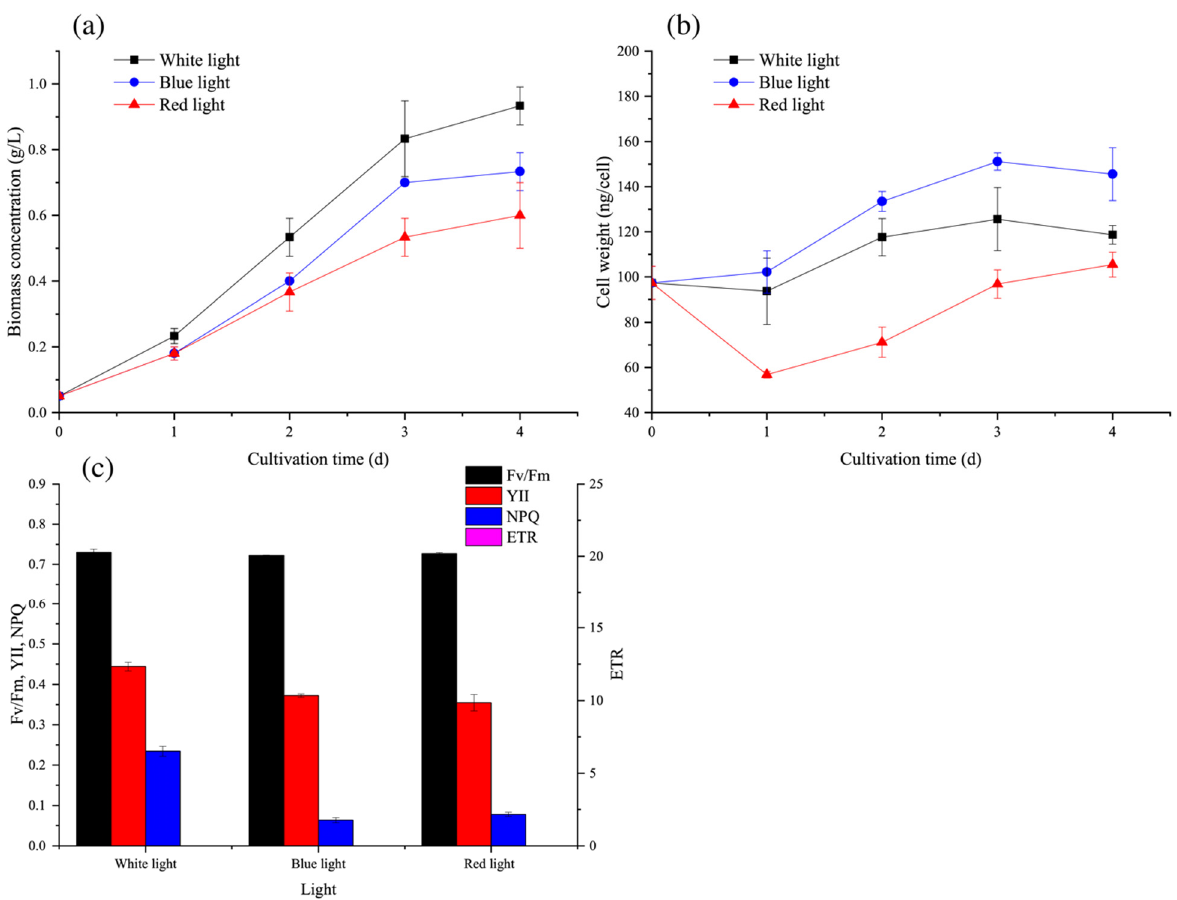
Figure 2. Effect of light wavelength on ( a ) biomass concentration; ( b ) cell weight; and ( c ) photosystem II on the 4th day of C. reinhardtii under N ‐ repletion. Data are presented in the form of mean ± the standard deviation ( n = 3). As for the effects of light quality on photosystems (Figure 2c), the YII, ETR, and NPQ values under white light were all significantly higher than those under blue and red lights ( p < 0.05), suggesting that the working efficiency of the photosystem was actively stronger under white light. Meanwhile, there were no significant differences in F v /F m values, indi ‐ cating no inhibition on photosynthesis under blue and red lights. 3.2. Effects of Light Wavelengths on Cell Growth and Cell Cycle under N ‐ Recovery Under N ‐ recovery, the effects of different light on cell enlargement and division were considerably distinct compared with those under N ‐ repletion ( p < 0.05). Under N ‐ recov ‐ ery, white light exhibited a greater potential in promoting cell growth than red and blue lights, which was in accordance with the results under N ‐ repletion (Figures 3a, S2 and S3). It is worth noting that during the initial 4 h of treatment, blue light increased cell number with a lower cell weight than the other two lights (Figures 3a and S4). Interestingly, alt ‐ hough blue light was acknowledged to effectively upregulate the transcription factors of cell enlargement [22], it was demonstrated in this study to promote cell division under N ‐ recovery.